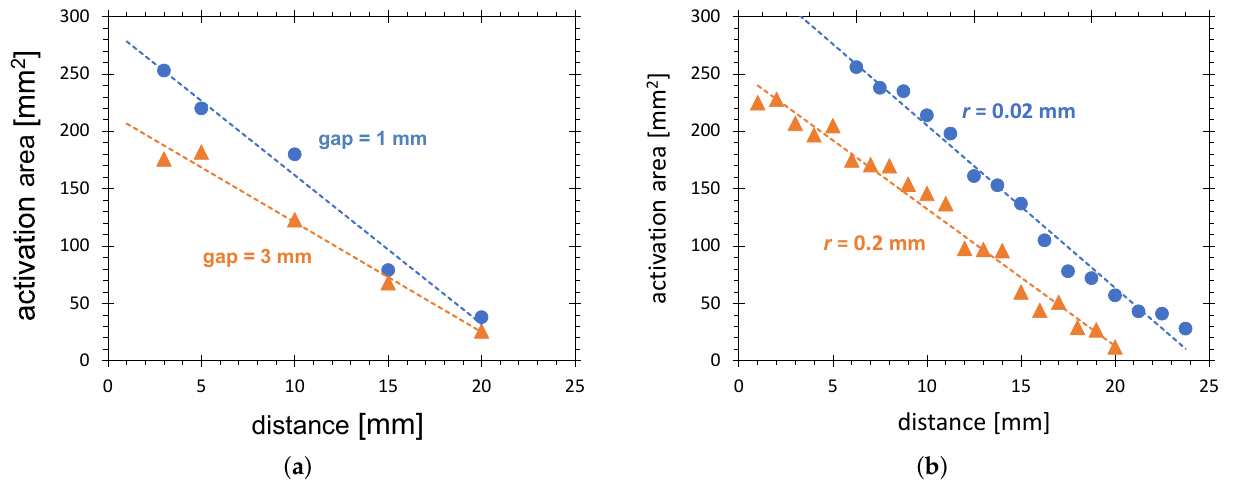
Figure 19. The dependence of the activation area on the distance between the needle tip and the substrate surface: ( a ) for two sizes of the gap between the PCPG and the needle head and ( b ) for two needle tip radii. During treatment, the piezobrush ® PZ3 needle nozzle was operated in air with the PCPG power of 8.0 W. The 2 mm thick HDPE substrate is placed on a grounded aluminum